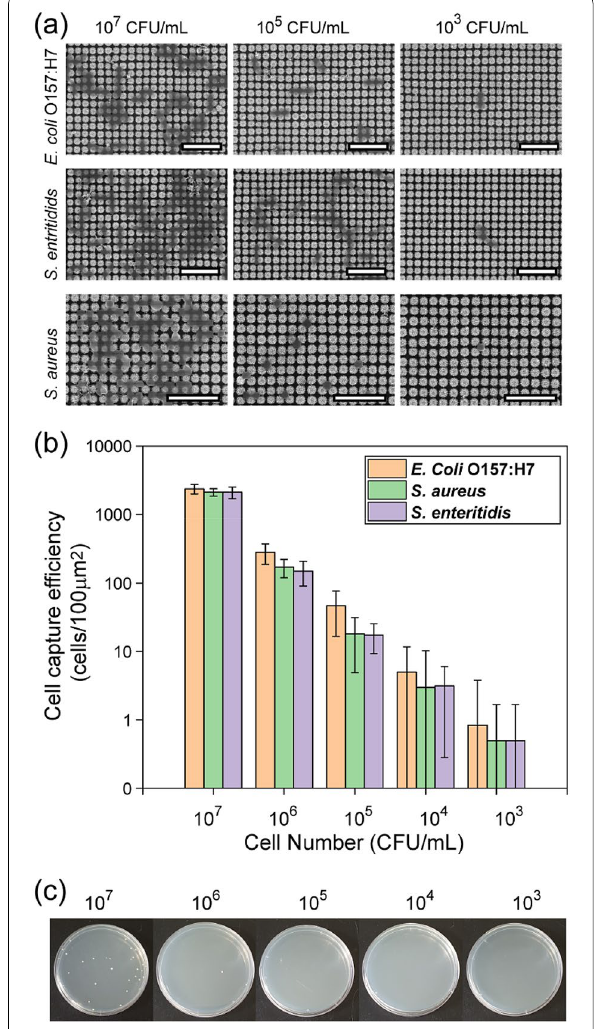
Fig. 4 a SEM images of 3D HPN captured E.coli O157:H7, S. enteritidis , and S. aureus cells at a cell number of 10 3 , 10 5 , and 10 7 CFU/mL. Scale bars are 5 μm. b Cell capture efficiency results of 3D HPN at a different cell number from 10 3 to 10 7 CFU/mL via touching. c Representative images of the colony‑counting assay results after rubbing E.coli O157:H7 captured 3D